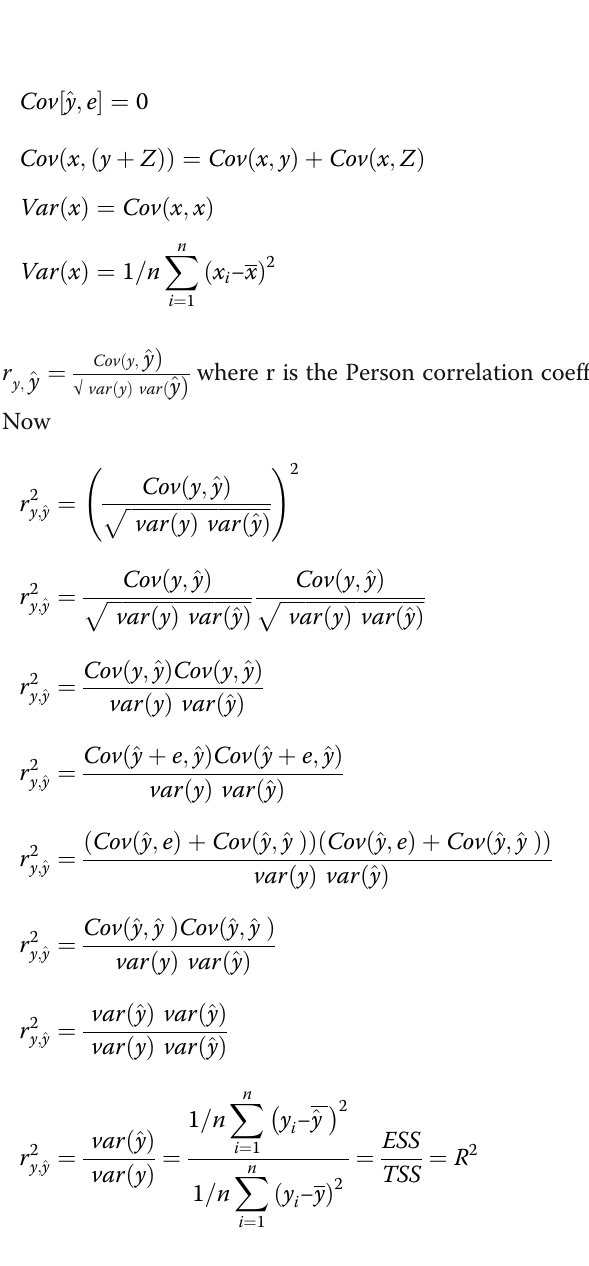
var y ð Þ var ^ y ð Þ